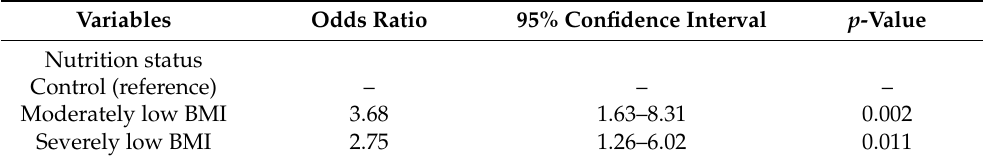
Table 5. Logistic regression analysis for 90-day readmission in survival